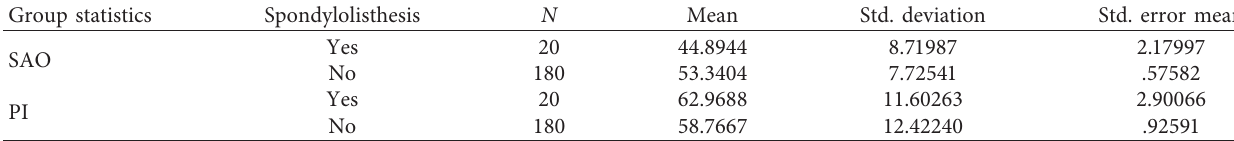
Table 1: Group statistics of SAO and PI between control and spondylolisthesis